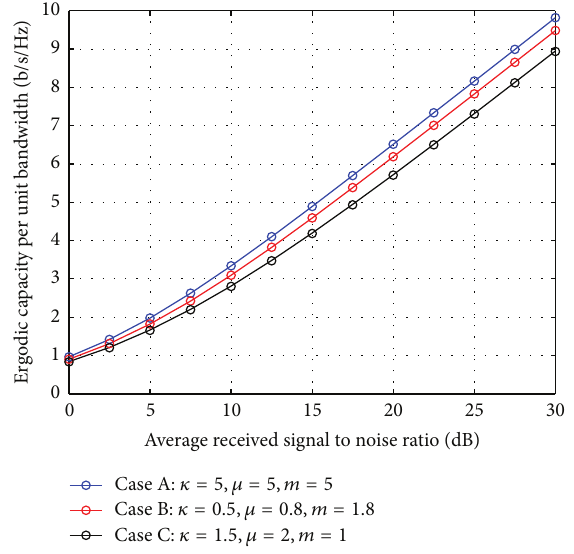
Figure 1: Representation of mean capacity values for different kinds of analytical solutions. The marks correspond to results obtained by numerical simulation.